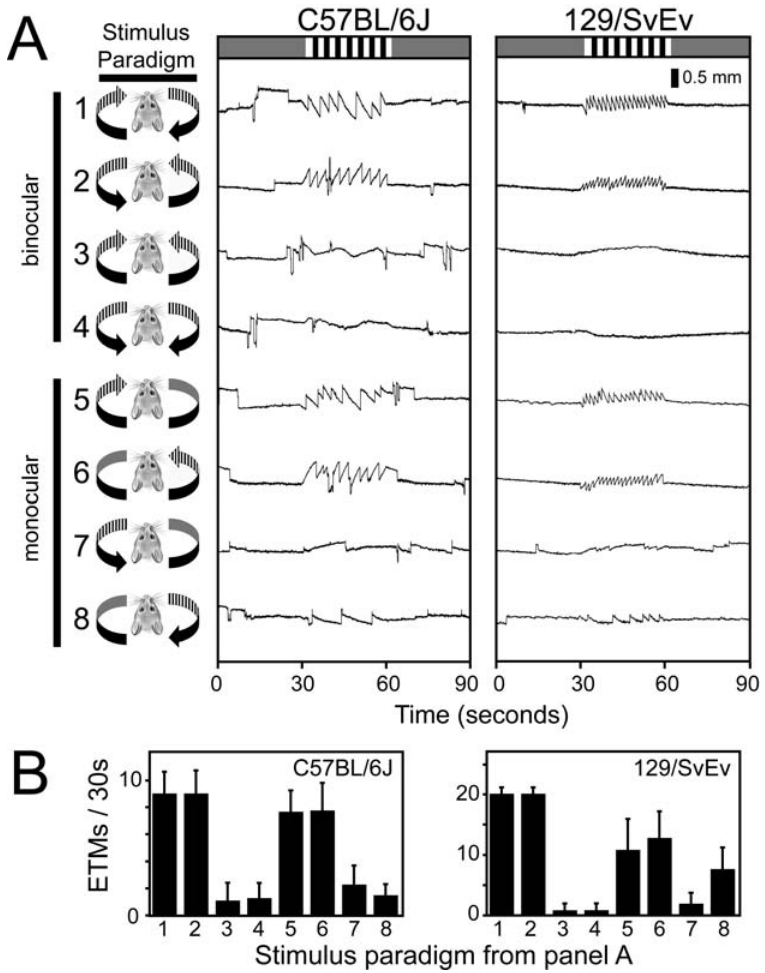
Figure 6. The sensitivity of the OKR in 129/SvEv and C57BL/6J mice to monocular or binocular rotation in temporal-to-nasal or nasal-to-temporal directions. (A) Left, schematic of the geometry of the stimulus. The OKR is always recorded from the right eye, and standard stimulus parameters are used (Figure 2). Rows 1 and 2 show responses to standard clockwise or counterclockwise rotation. Rows 3 and 4 show the nulling of mirror symmetric temporal-to-nasal or nasal-to-temporal stimuli. Rows 5 and 6 show the strong response to monocular stimuli in the temporal-to-nasal direction delivered to either the contralateral or ipsilateral eye. Rows 7 and 8 show the weak response to monocular stimuli in the nasal-to-temporal direction delivered to either the contralateral or ipsilateral eye. For monocular moving stimuli (rows 5–8), an intensity-matched uniform grey stimulus was delivered to the contralateral eye. (B) Quantifying the number of ETMs/30 seconds for the stimuli tested in panel (A). Mean + / 2 standard deviation for . 6 mice for each strain and 25–39 30-second stimulus intervals per condition. N, nasal; T,